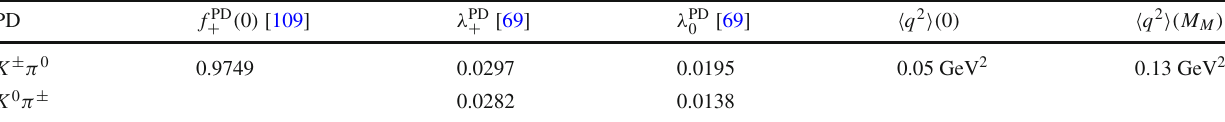
Table 7 Parameters entering our form factor definitions for the semileptonic K → π n (cid:13) decays, and the value of (cid:9) q 2 (cid:10) ( M 4 ) for M 4 = 0 and M 4 = M M . See text for details. Note that we make use of different parameters for the decays of charged and neutral kaons, following Ref. [69]